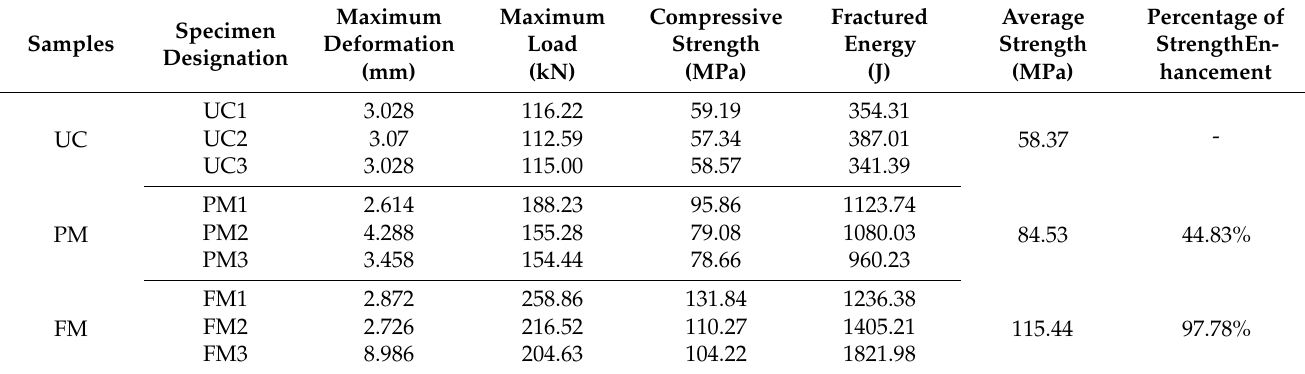
Table 3. Summary of mechanical properties of test